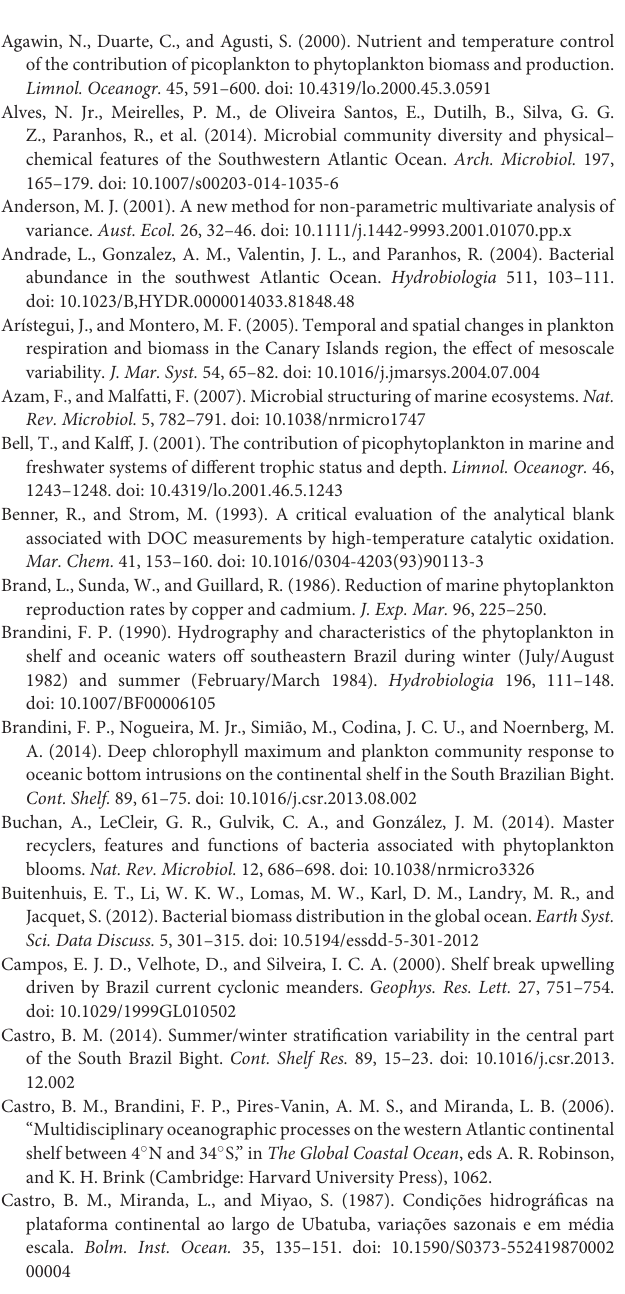
temperature ( ◦ C), salinity (psu), fluorescence (RFU), phosphate ( µ M), silicate ( µ M), nitrite ( µ M), nitrate ( µ M), ammonia ( µ M), dissolved organic carbon (mg.L − 1 ), dissolved organic nitrogen (mg.L − 1 ). Table S2 | Cell abundance (cell.mL − 1 ) of Synechococcus spp. (SYN), Prochlorococcus spp. (PRO), picoeukaryotes (PEUK), nanoeukaryotes (NANOEUK) and heterotrophic bacteria (HBAC) for each sample, considering the ship station, latitude ( ◦ N), longitude ( ◦ E), sampling depth (m), and the corresponding water